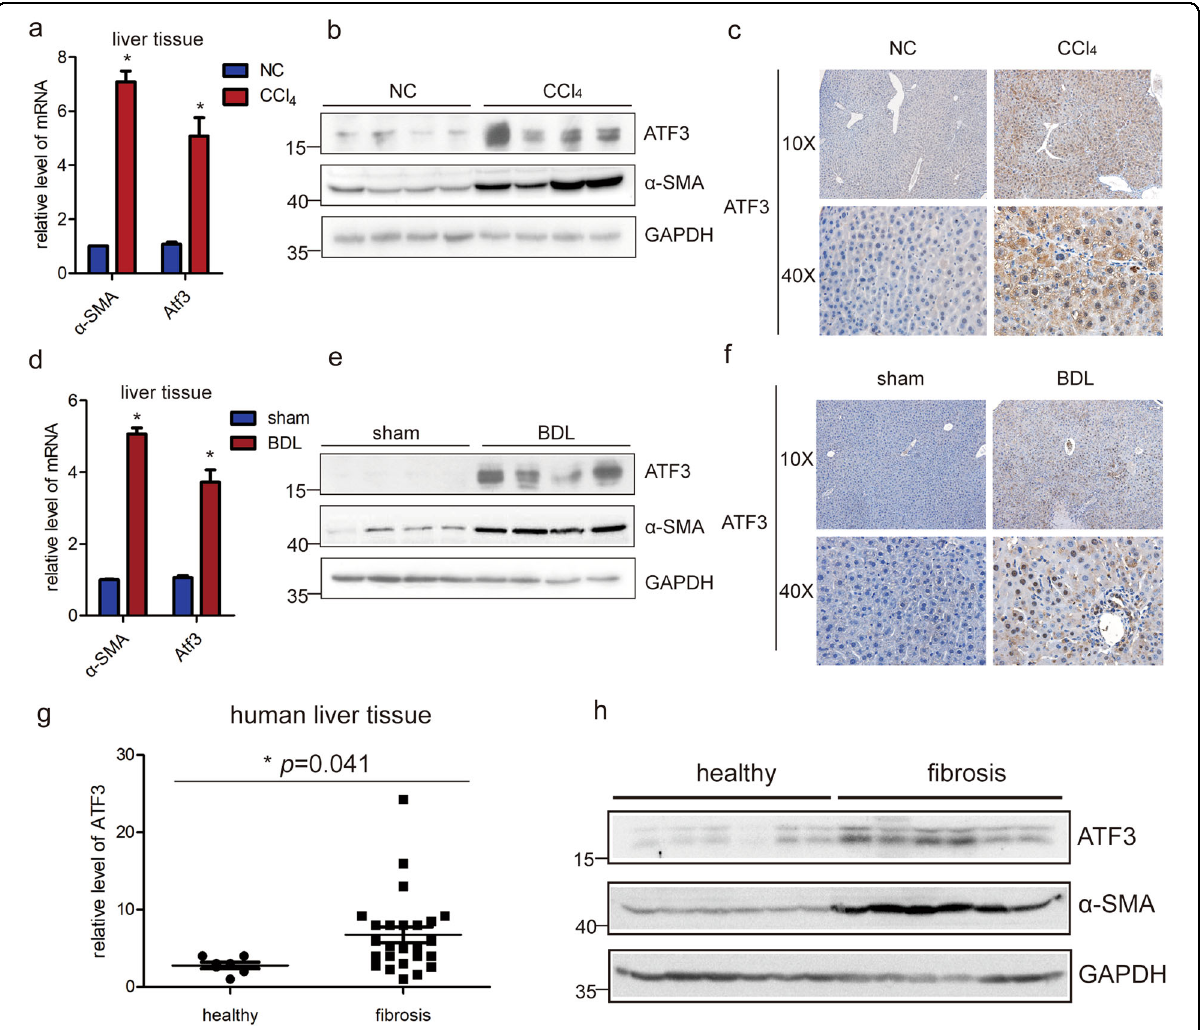
immunoblot in livers from mice treated with CCl 4 for 8 weeks. c The expression of ATF3 was examined in CCl 4 -induced fi brotic livers using IHC staining, 10× and 40× magni fi cation. d , e The expression of ATF3 and α -SMA was assessed by qRT-PCR analysis and immunoblot in livers from mice that underwent BDL for 21 days. f The expression of ATF3 was examined in BDL-induced fi brotic livers using IHC staining, 10× and 40× magni fi cation. g , h The expression of ATF3 was assessed by qRT-PCR analysis and immunoblot in liver samples of healthy people and fi brotic patients. The data were expressed as the mean ± SD for at least triplicate experiments, GAPDH was used as an internal control; * p <